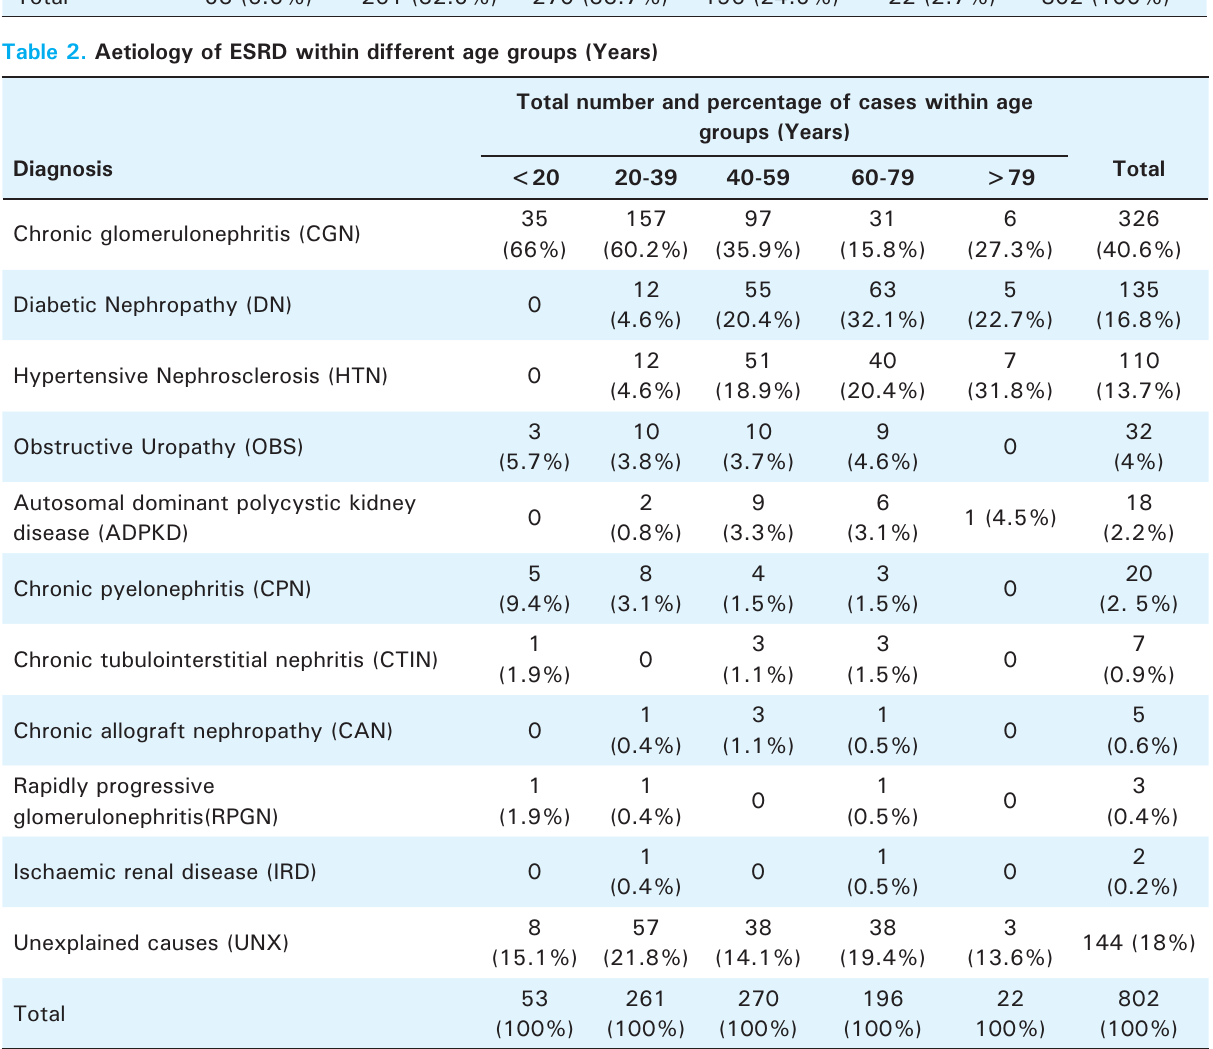
Total number and percentage of cases within